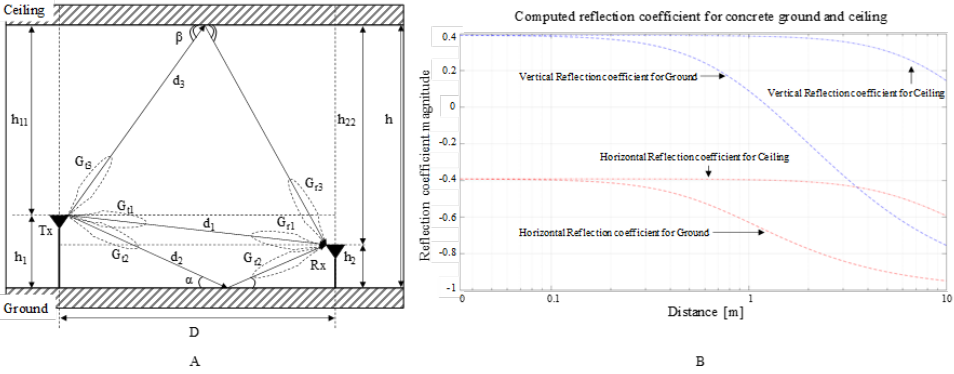
Figure 6. MATLAB signal attenuation simulation by using the Three-ray and Free space models for 868 MHz and 2.4 GHz for following the scenario described in ( A ), resulting in a computed reflection coefficient versus distance for the concrete ground and ceiling such illustrated in ( B ).